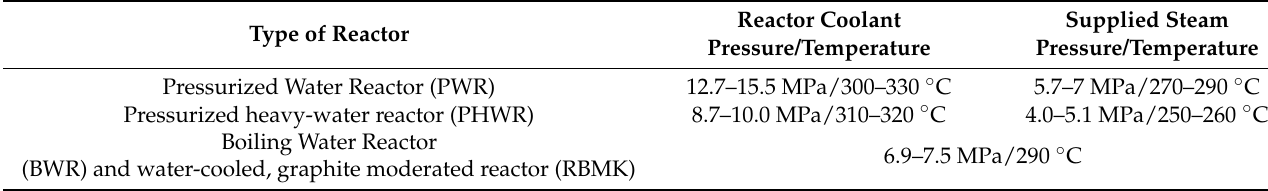
Table 5. Water-cooled reactor classes and operating steam parameters.